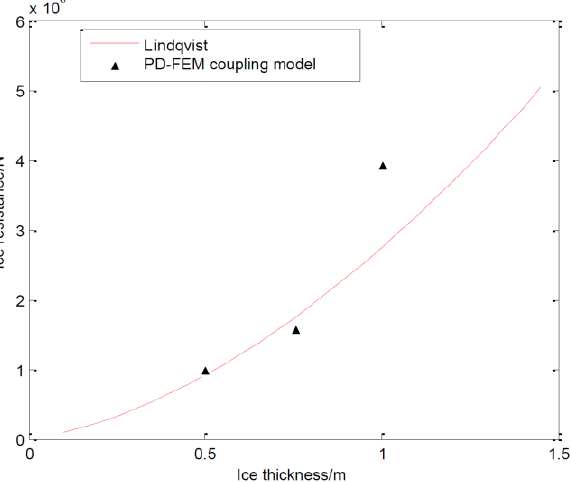
Figure 16. Ice resistance obtain by Lindqvist formula and FEM-PD coupling model for different ice thicknesses.